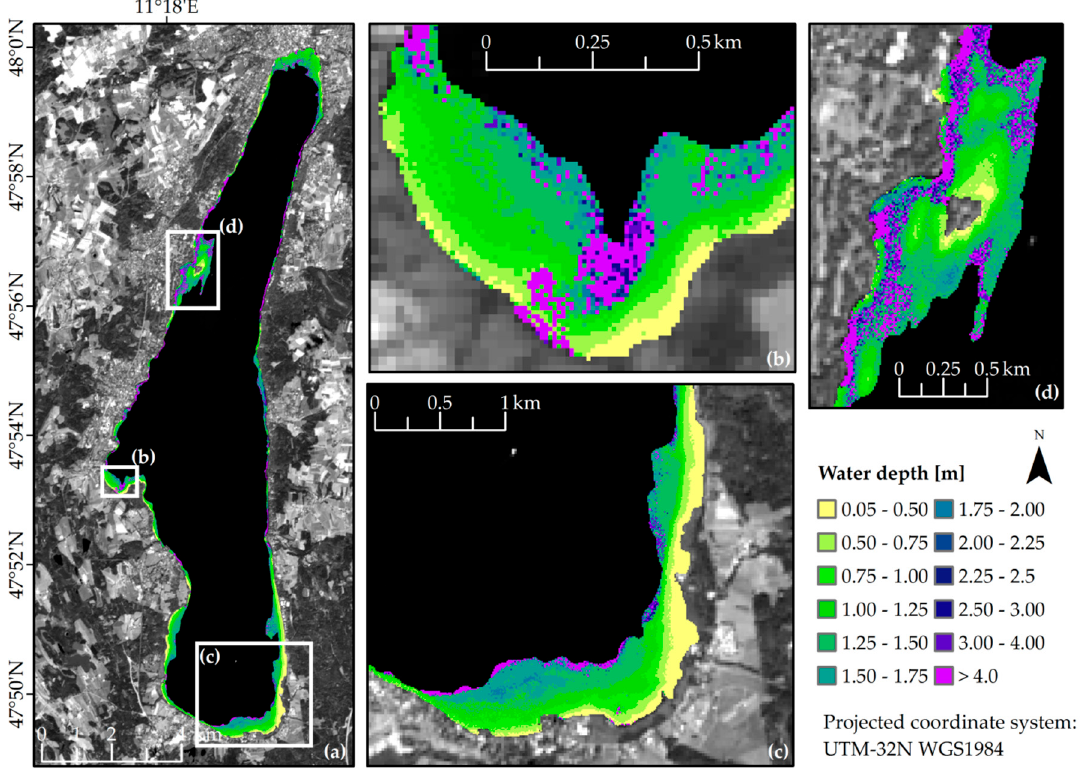
Figure 9. Results of water depths retrieval during shallow water inversion using the MIP 10 m pixel size dataset ( a ); Zoomed areas are Karpfenwinkel ( b ); validation area Seeshaupt ( c ) and Roseninsel ( d ). Background is gray scaled S2-A band B05 (705 nm).